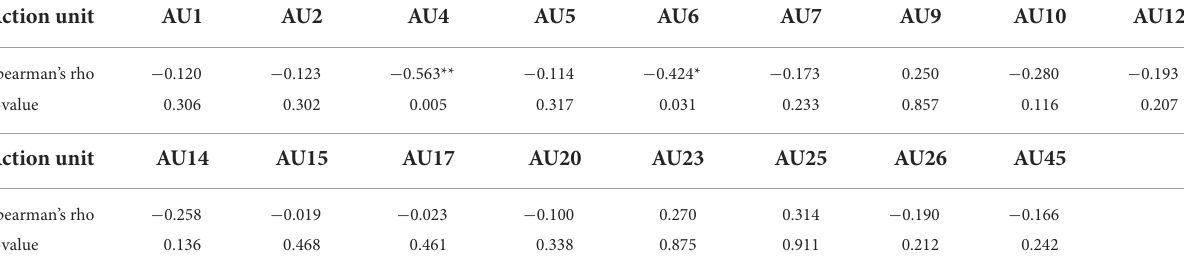
TABLE 9 Spearman’s correlations r (20) with the mean scores of DC items 7 and 8, taken as an overall indicator of users’ experience. Action